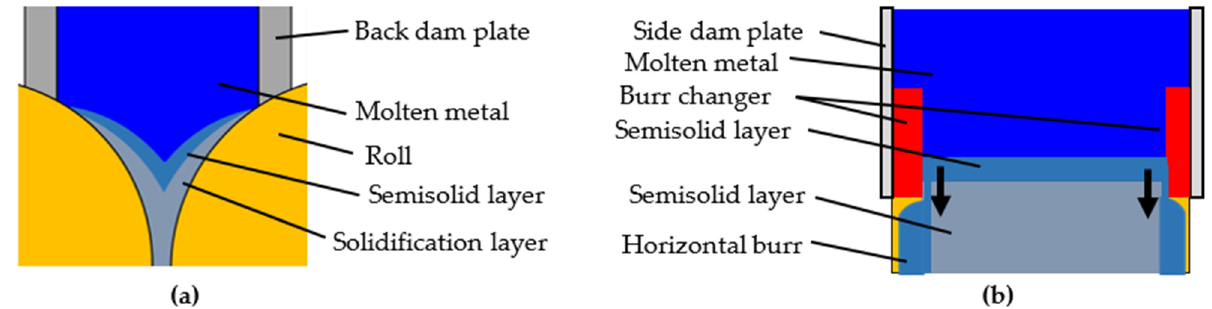
Figure 10. Schematic illustration of a cross section vertical to the roll shaft near the center of the roll and a cross section parallel to the roll shaft at the roll bite with a burr changer. ( a ) cross section vertical to the roll shaft near the center of the roll, ( b ) cross section parallel to the roll shaft at the roll bite with a burr.